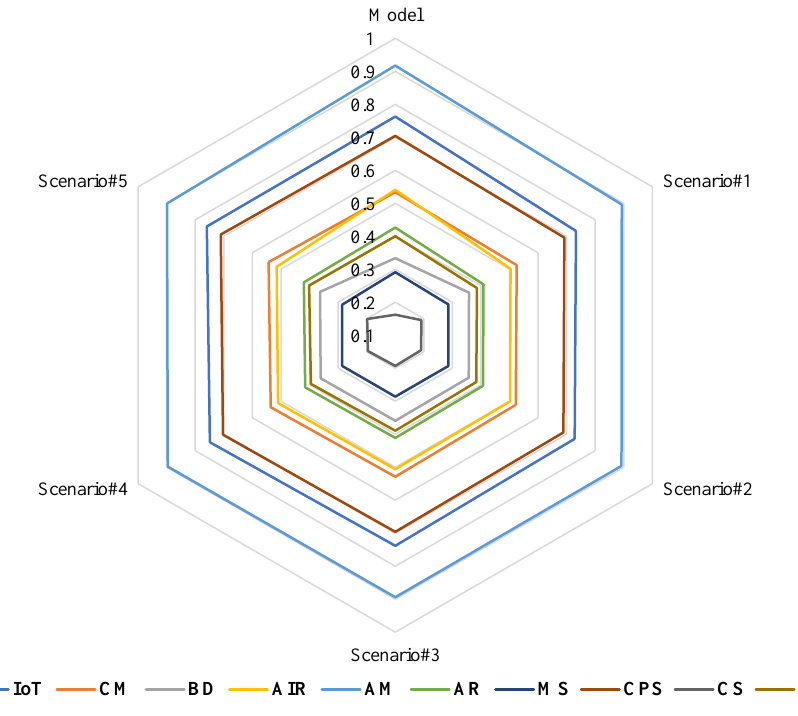
Figure 6. Sensitivity analysis.